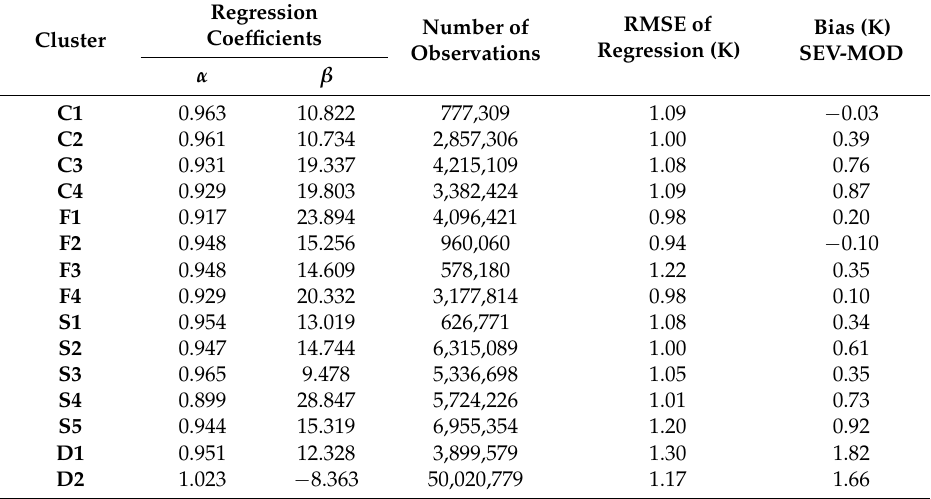
Table 1. Regression coefficients of the bias correction performed between MODIS and SEVIRI land surface temperature (LST) products. The number of observations used in the regression, Root Mean Square Error (RMSE) of the regression and overall bias between MODIS and SEVIRI (as SEVIRI minus MODIS) for each cluster are also